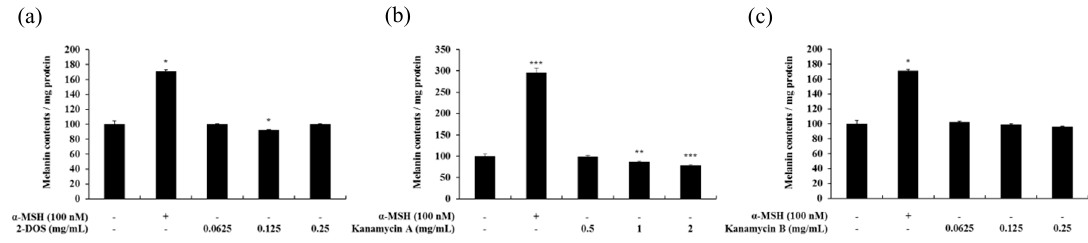
Figure 11. Cell viability of kanamycin A-( a ), kanamycin B-( b ), and 2-DOS-( c ) treated B16F10 melanoma cells. Cells were treated with various concentrations of these drugs for 72 h. Data are presented as mean ± standard deviation (SD) of at least four independent experiments ( n = 4). * indicates p < 0.05, ** p < 0.01, *** p < 0.001 vs. untreated cells. Figure 12. Melanin contents in 2-DOS-( a ), kanamycin A-( b ), and kanamycin B-( c ) treated B16F10 melanoma cells. The cells were treated with various concentrations for 72 h. α -MSH was used as a positive control. Melanin concentrations are expressed as percentages compared to the respective values obtained for the control cells. Data are presented as mean ± standard deviation (SD) of at least four independent experiments ( n = 4). * indicates p < 0.05, ** p < 0.01, *** p < 0.001 vs. untreated cells.